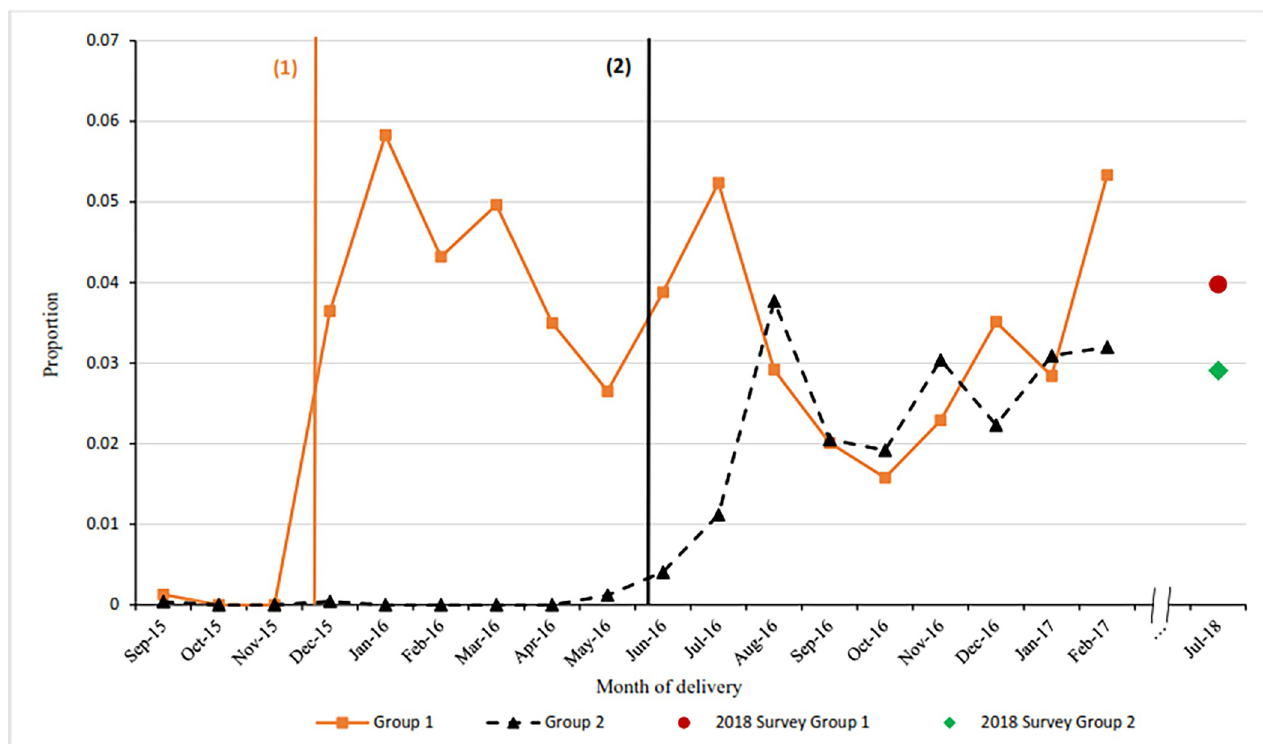
Fig 3. Proportion of women having a PPIUD inserted classified by month of delivery in